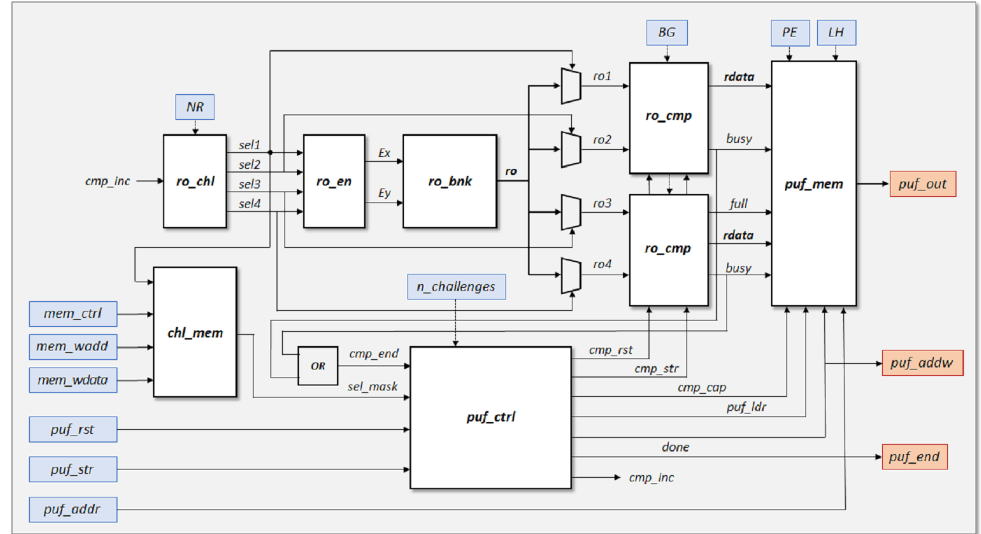
Figure 1. Block diagram of the proposed RO-PUF/TRNG design (blue and red boxes represent inputs and outputs,